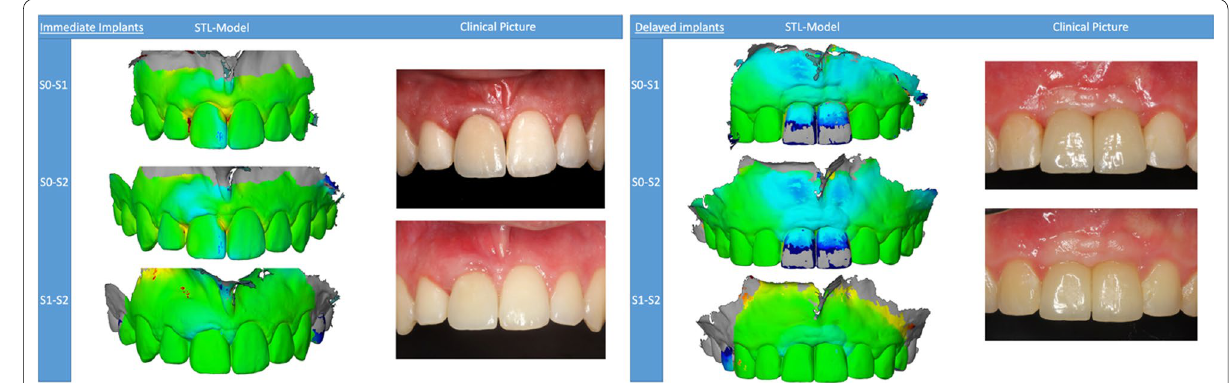
Fig. 3 Representative volumetric superimposition and clinical images. A Immediate implantation group, B delayed implantation group